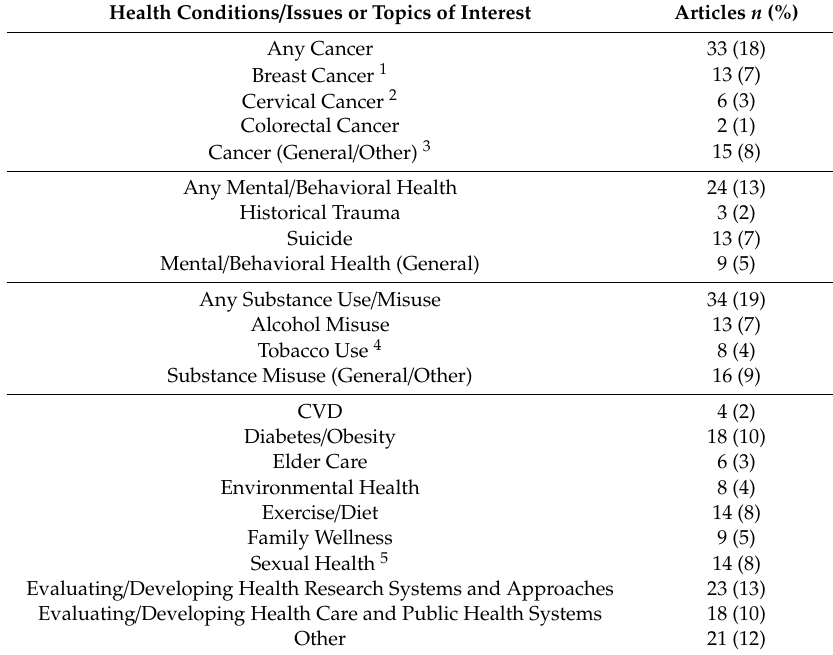
Table 1. Health Conditions / Issues of Interest in Articles Utilizing PR in AIAN Communities. Health Conditions / Issues or Topics of